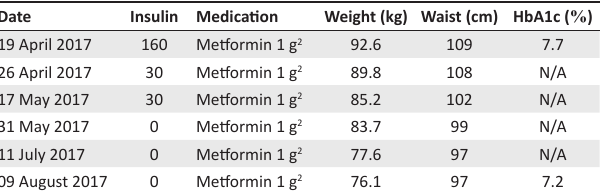
FIGURE 3: Change in waist circumference over the course of treatment. TABLE 1: Patient measurements at each